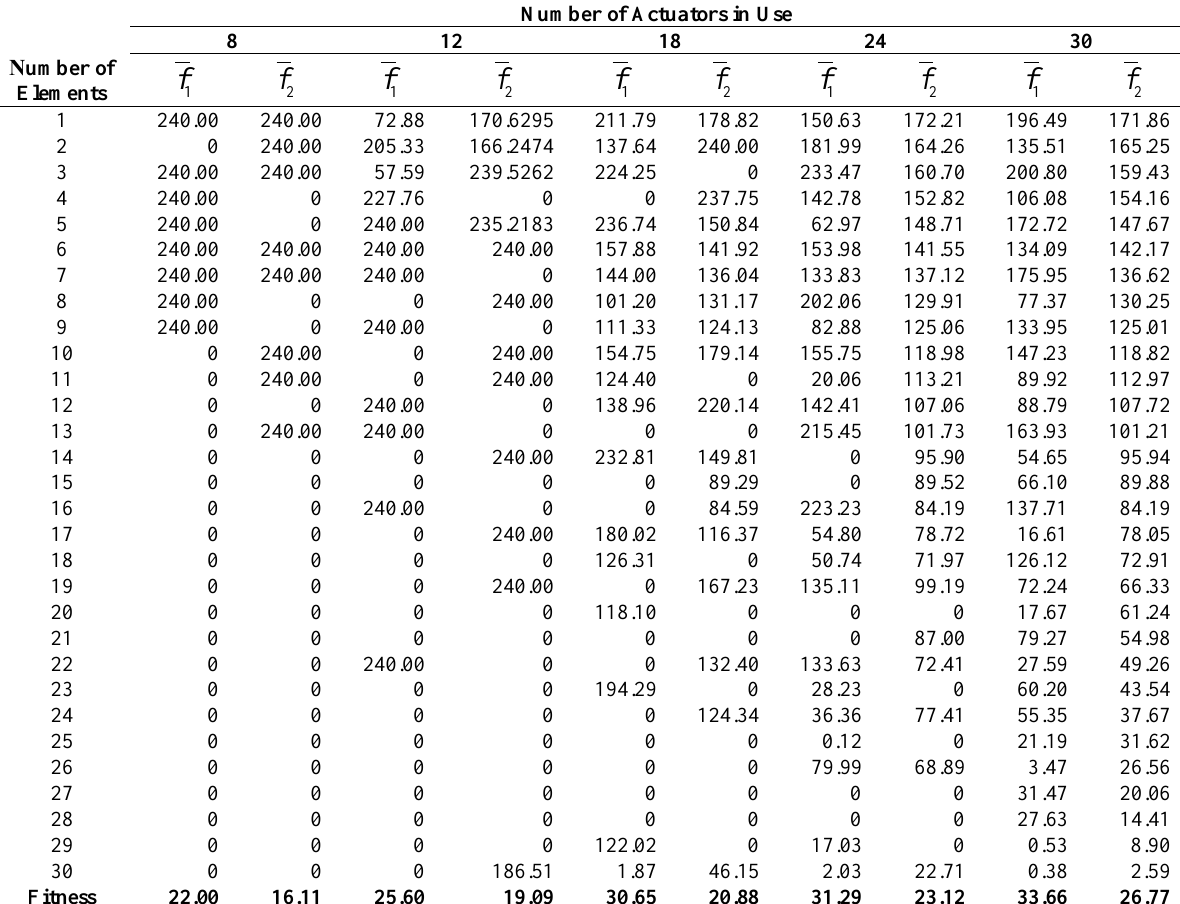
Table 2. Optimal Location and voltages of actuators within the 30 finite element mesh for Clamped−Free